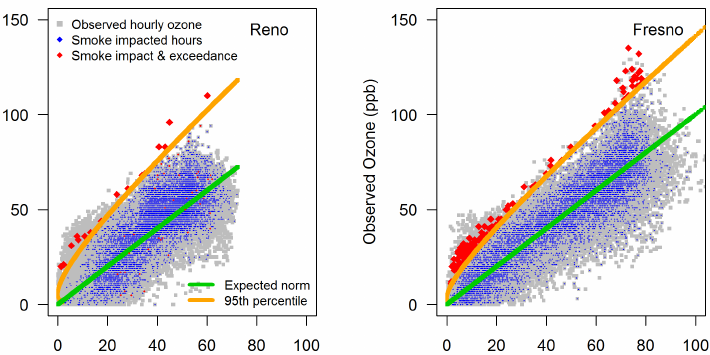
Figure 2. Observed ozone values against the expected norms for a given site day-in-year and weather condition at that hour. Observed ozone values above the estimated 95th percentile line are considered values in exceedance of the norm. Smoke impacted cases are times with “potential fire impact” as defined in